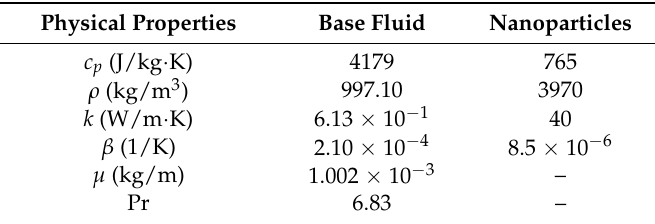
Table 1. Thermophysical properties of the base fluid and Al 2 O 3 nanoparticles that are used for estimating nanofluid